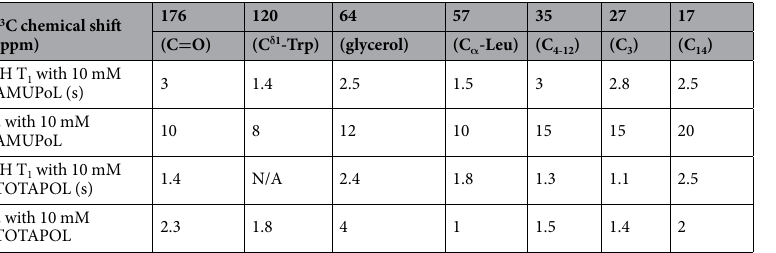
Table 1. Proton spin-lattice relaxation ( T 1 ) times and DNP enhancements obtained from selectively 13 C-labeled volume ratio) using proton saturation recovery with 13 C CP detection, and the signal enhancement ( ε ) of 13 C CPMAS spectra obtained from Fig. 1. The 1 H T 1 values were measured for selected 13 C resonances at 8.5 kHz MAS, 99.5 K sample temperature, and using 8 scans. Errors estimated for the reported T 1 values range from 0.001 to 0.03 s. Relaxation times measured without a DNP label are given in Supplementary Table